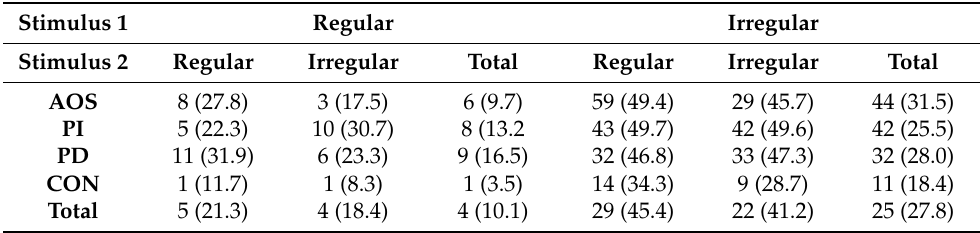
Table 2. Error rates in % (mean, s.d.) in the rhythm discrimination task across the four rhythmic conditions. Figures represent grand averages across patients and items. AOS: apraxia of speech ( n = 12); PI: phonological impairment ( n = 12); PD: Parkinson’s dysarthria ( n = 12); CON: healthy controls ( n = 24). Eight items per